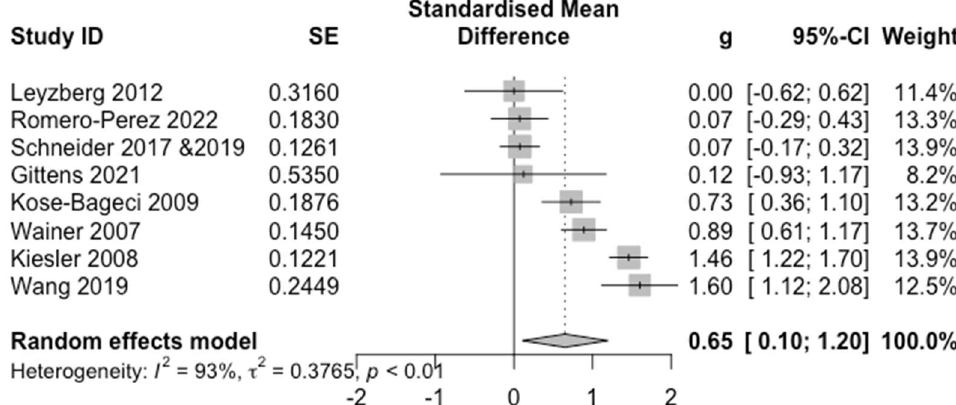
Figure 5. Forest Plot for PA. For each study and the average effect size, the plots show standardised mean differences (hedges’ g), standard error (SE), the 95% confidence interval (95% CI), and the weight in the random effect model. Heterogeneity is represented by the between study Higgins & Thompson’s 𝐼 (cid:2870) , heterogeneity variance τ (cid:2870) and p -value.